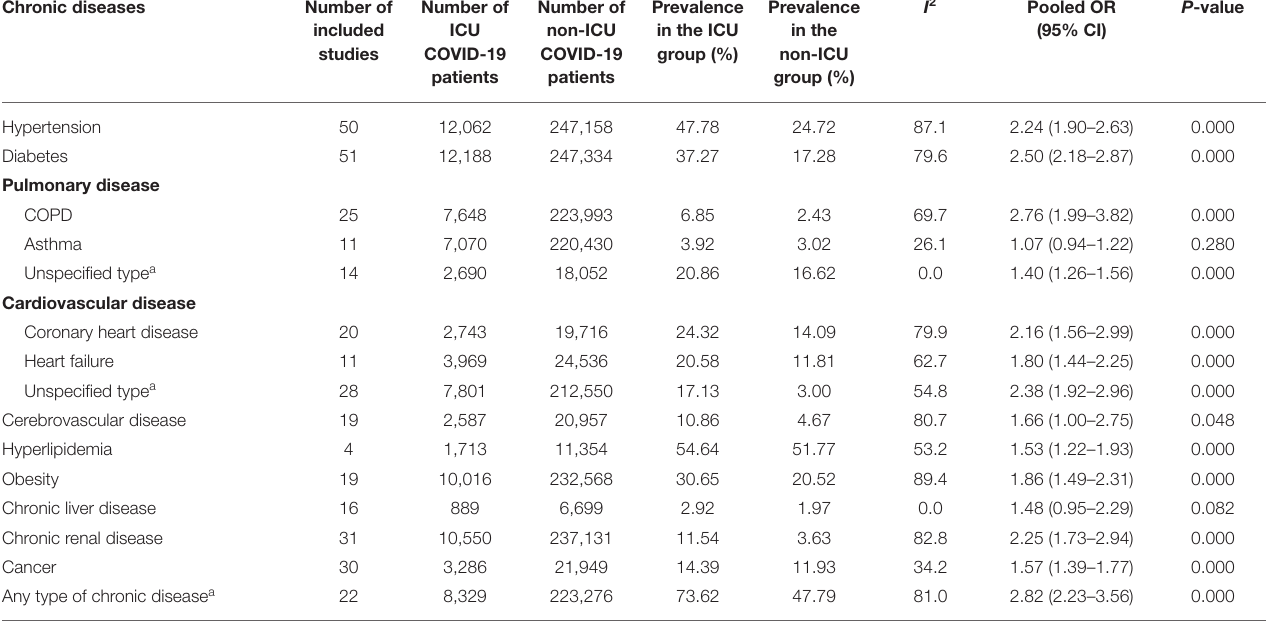
TABLE 4 | Associations between chronic diseases and ICU admission of COVID-19. Chronic diseases Number of